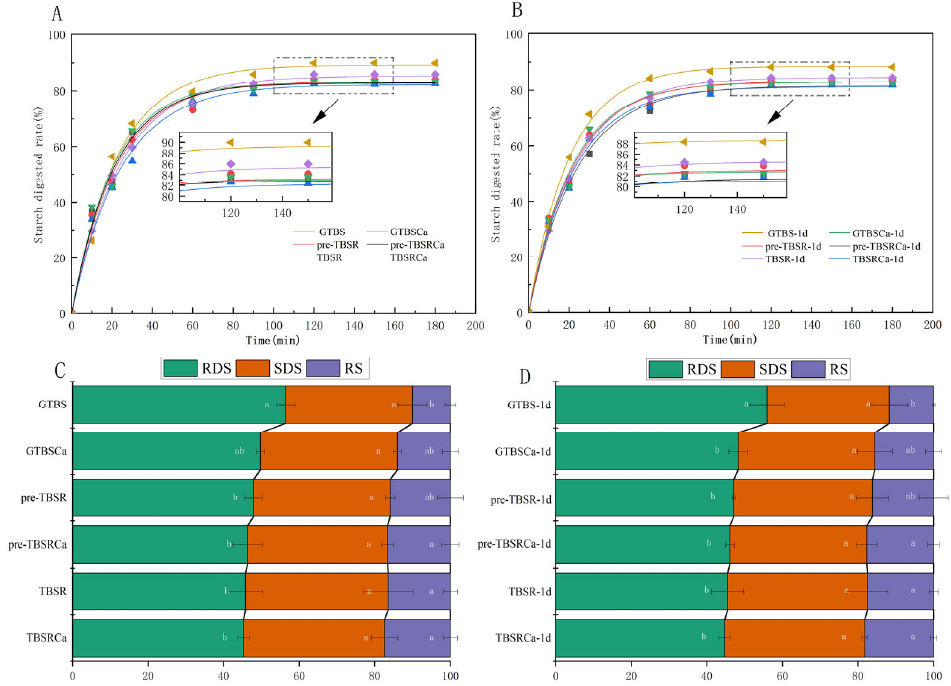
Figure 7. Starch hydrolysis pattern of GTBS, GTBSCa, pre-TBSR, pre-TBSRCa, TBSR, and TBSRCa complexes ( A ) and retrograded samples for 1 day ( B ); the starch fraction of samples ( C ) and retro- graded samples for 1 day ( D ). Different lowercase letters in columns of the same color indicates significant differences ( p < 0.05) of same starch fractions among